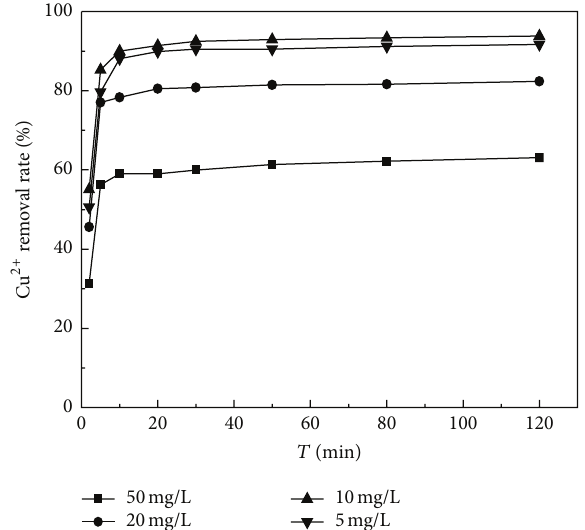
Figure 5: Effect of initial concentration and contact time on Cu(II) adsorption (conditions: adsorbent dose = 5g/L, pH = 5, temp. = 25± 1 ∘ C, and stirring rate = 150 rpm).